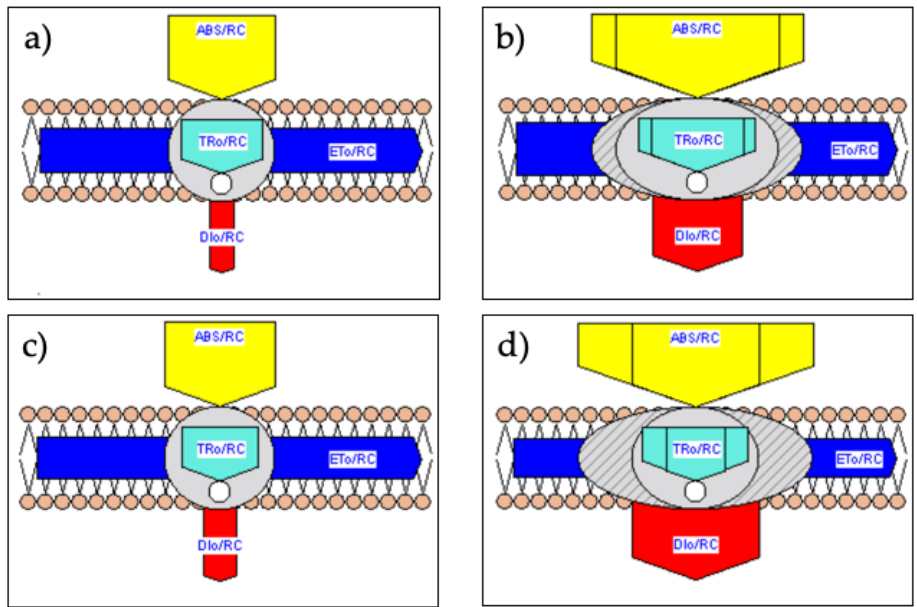
Figure 5. Pipeline models of energy fluxes per active reaction center (membrane/specific model) for S0 (panels a , c ) or S120 (panels b , d ) of QA (panels a , b ) or CG (panels c , d ). Each energy flux is depicted as an arrow, whose width is proportional to the relative flux. The lateral area in the ABS/RC and TRo/CS M represents the energy fluxes related to non-Q A reducing centers (inactive or silent RC). The software Biolyzer produced the pipelines from the average transient curve of 24 replicates measured on DAT